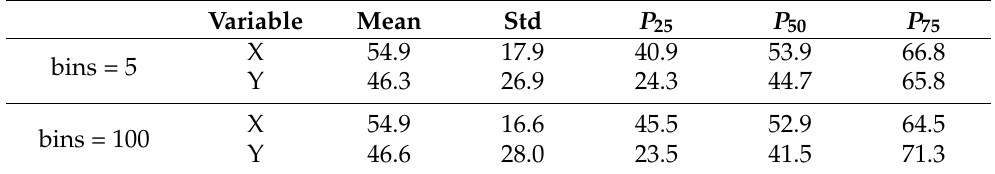
Table 5. Summary statistics for selected plots of Figure